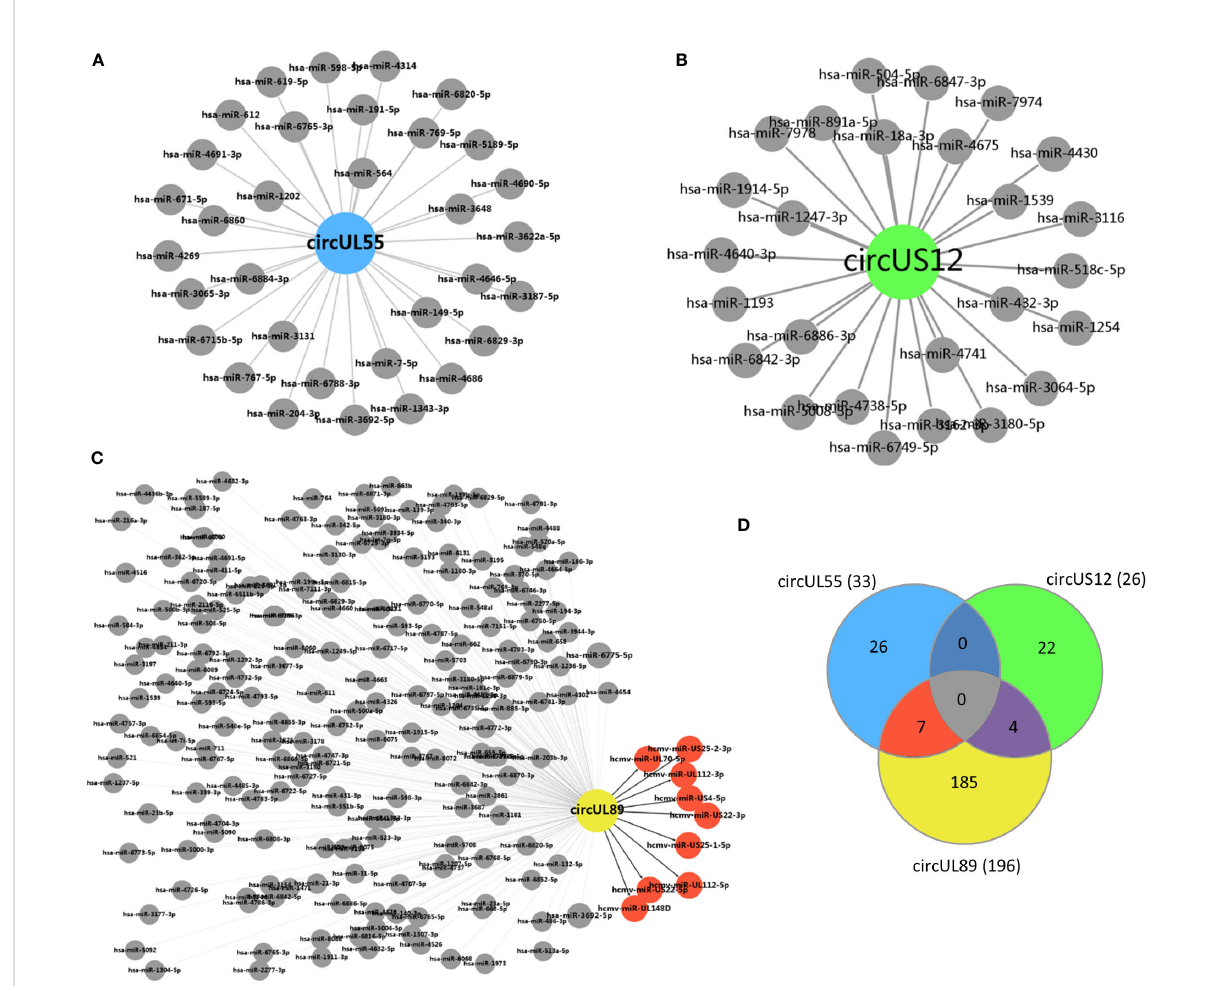
FIGURE 6 Prediction of putative target miRNAs of HCMV circUS12, circUL55, and circ UL89. (A – C) Prediction of putative target miRNAs of HCMV circUS12, circUL55, and circUL89. The putative cellular miRNAs of HCMV circUS12, circUL55, and circUL89 were 26, 33, and 196, respectively. Especially, nine HCMV-derived miRNAs were predicted to be the target of circUL89. (D) Venn diagram showing the number of unique or shared target miRNAs of circUS12, circUL55, and